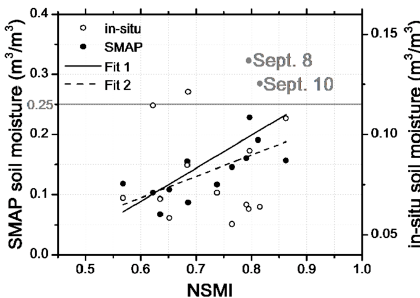
Figure 4. Extraction of variance conversion factor. Black dotted data are SMAP soil moisture relative to the NSMI at 36 km resolution, among which SMAP values exceeding 0.25 m 3 /m 3 are emphasized in gray. Hollow circles are in situ soil moisture with respect to the NSMI aggregated at the 36 × 36 km 2 scale. It should be noted that the study used SMAP soil moisture and NSMI for extracting the variance conversion factor and used the OzNet in situ soil moisture network for ancillary validation of such a